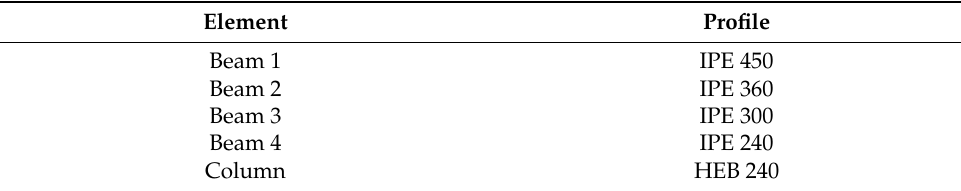
Table 13. Beam and column cross-sections of all of the multi-storey case studies (from 5 to 8) after the vertical static analysis design.